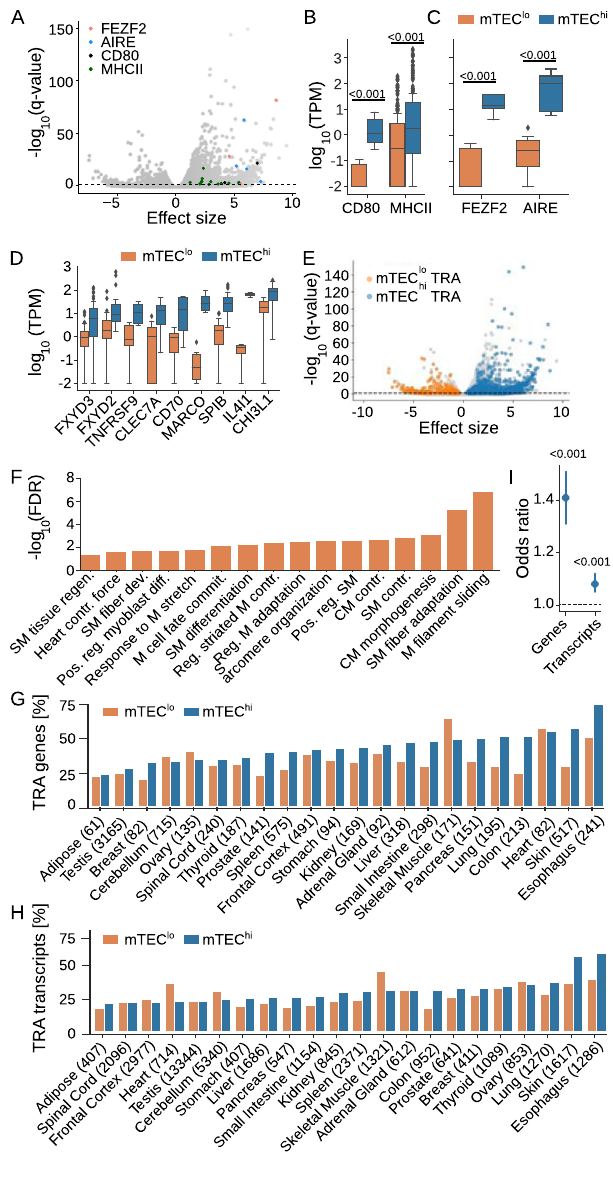
Fig. 4 Differential expression of tissue-restricted antigens across mTEC populations. A Enrichment of the mature mTEC marker CD80 and